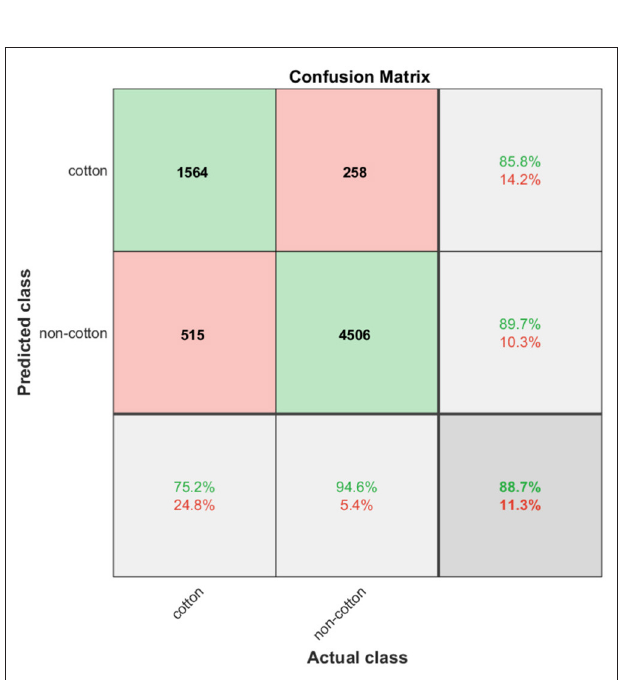
FIGURE 8 | Confusion matrix chart. Green cells show the number of correct classifications by the SVM model. Red cells show the number of classification errors. Gray cells show overall performance of the